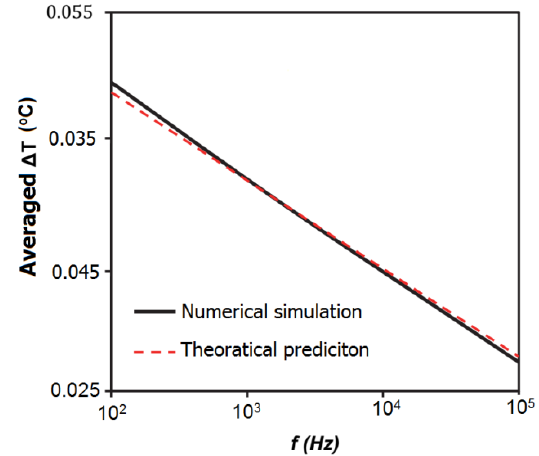
Figure 7. A comparison between the numerical simulation and theoretical prediction results (Equation (2)) on ∆ T versus f .